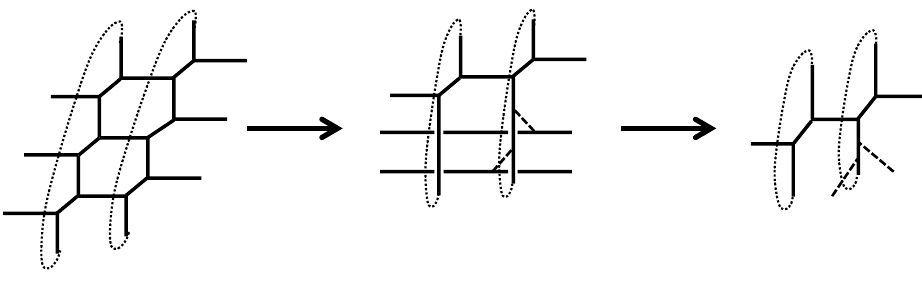
Figure 5 . The geometric